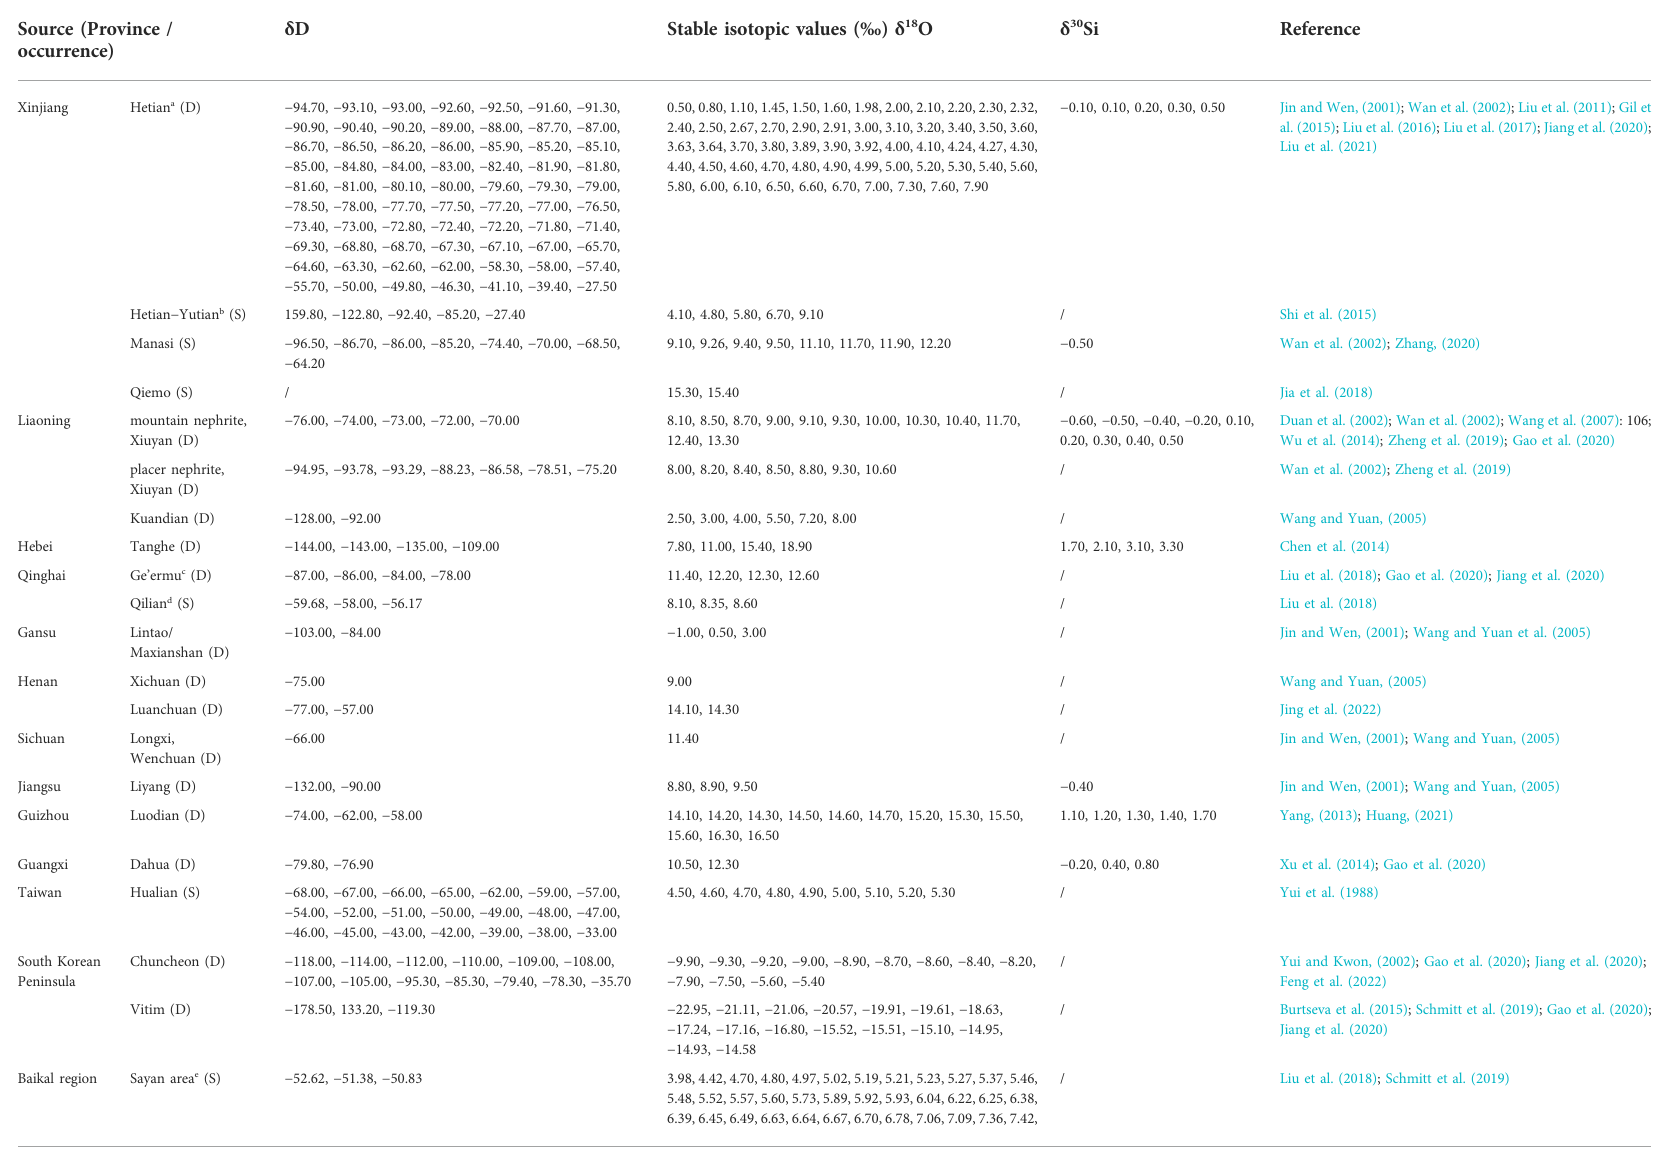
TABLE 2 Stable isotopic values of modern nephrite